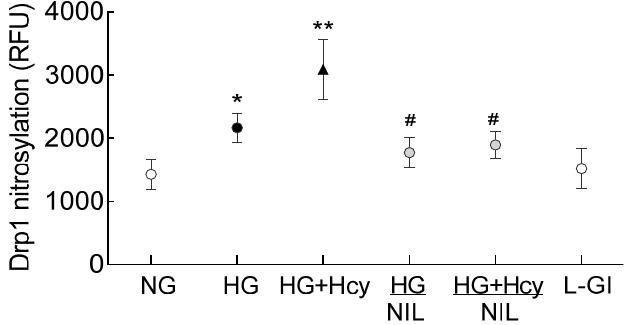
Figure 7. Effect of homocysteine on Drp1 nitrosylation. Drp1 nitrosylation was determined by following the conversion of 2,3-diaminonaphthalene to fluorescent 2,3-naphthyltriazole. The values presented are mean ± SD from 3–4 different cell preparations with each measurement made in duplicate: NG and HG, cells in normal and high glucose respectively; HG + Hcy, cells in high glucose + homocysteine; HG/NIL and HG + Hcy/NIL, cells in the presence of NIL in high glucose or high glucose + homocysteine, respectively; L-Gl, 20 mM L-glucose; * and ** p < 0.05 vs. NG and HG, respectively; # p > 0.05 vs. NG.